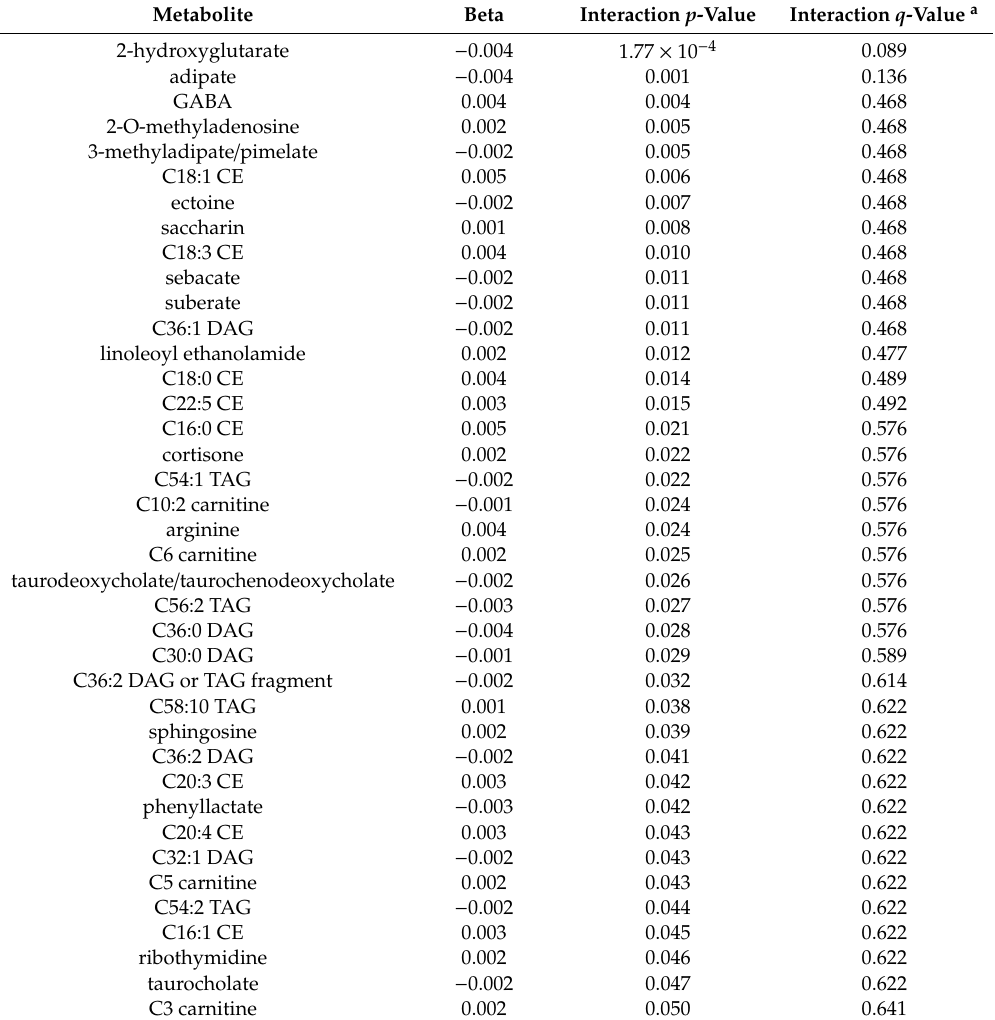
Table 2. Metabolites significantly interacting with age in BDR in